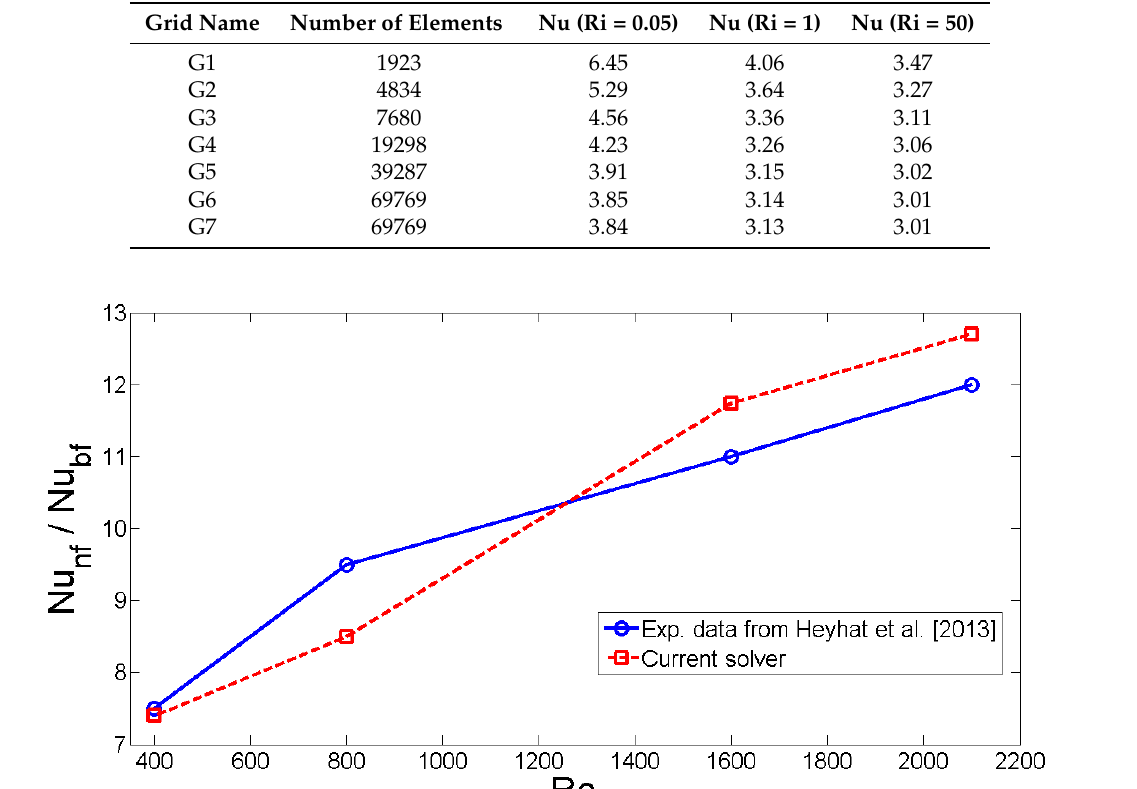
Figure 2. Ratio of the Nusselt number of nanofluid to pure water obtained in the experimental work in Ref. [59] and calculated with the current